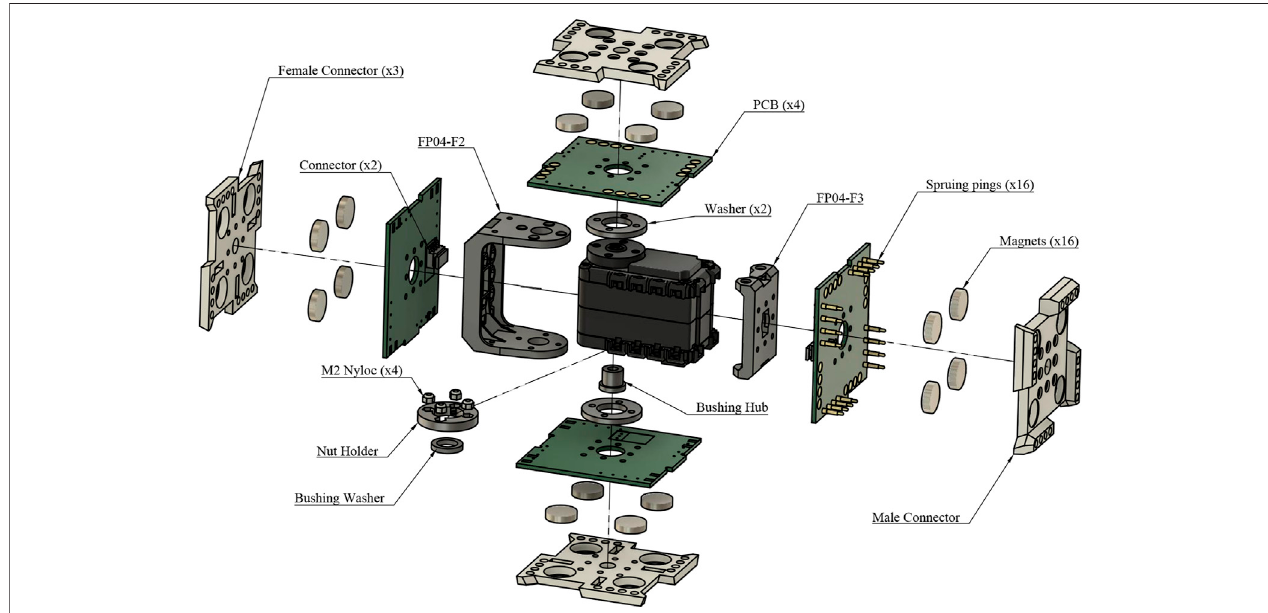
FIGURE 3 | An exploded view of the EMERGE Module. The screws or rivets used to join the four connectors and the brackets (FP04-F2 and FP04-F3) have not been included for the sake of clarity.